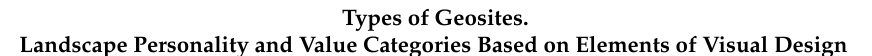
Table 7. Information and geomorphic, geologic, and cultural details concerning the geodiversity of the Shahdad region, which make the geosites attractive through landscapes for geotourism and the development of geoparks. Types of Geosites.